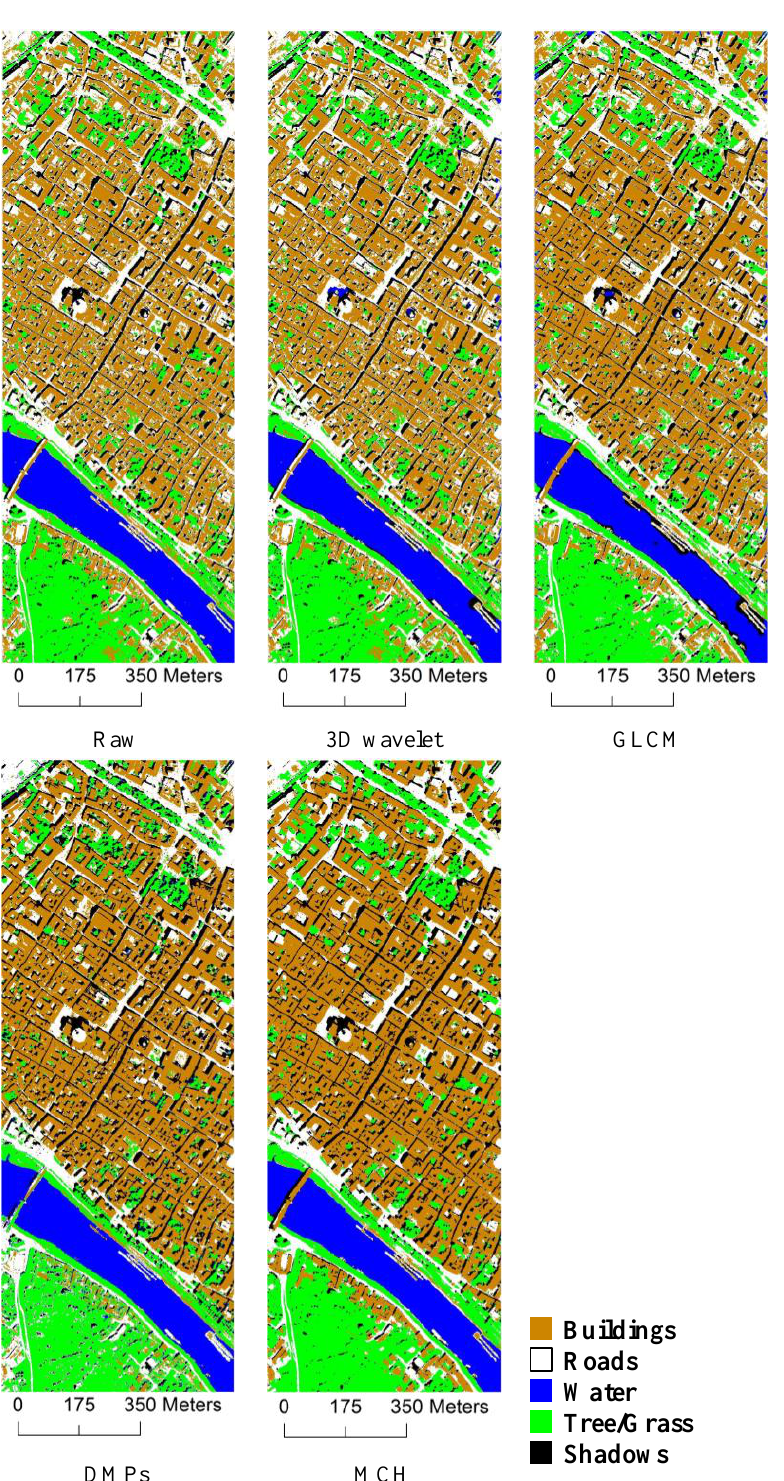
Figure 12. An overview of the classification maps for the Pavia City